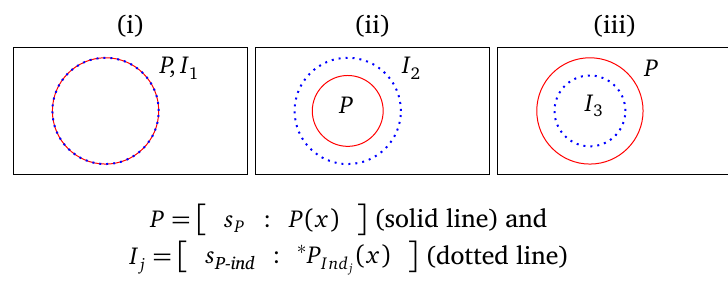
Figure 4: Maximising both conditional probabilities vs. maximising